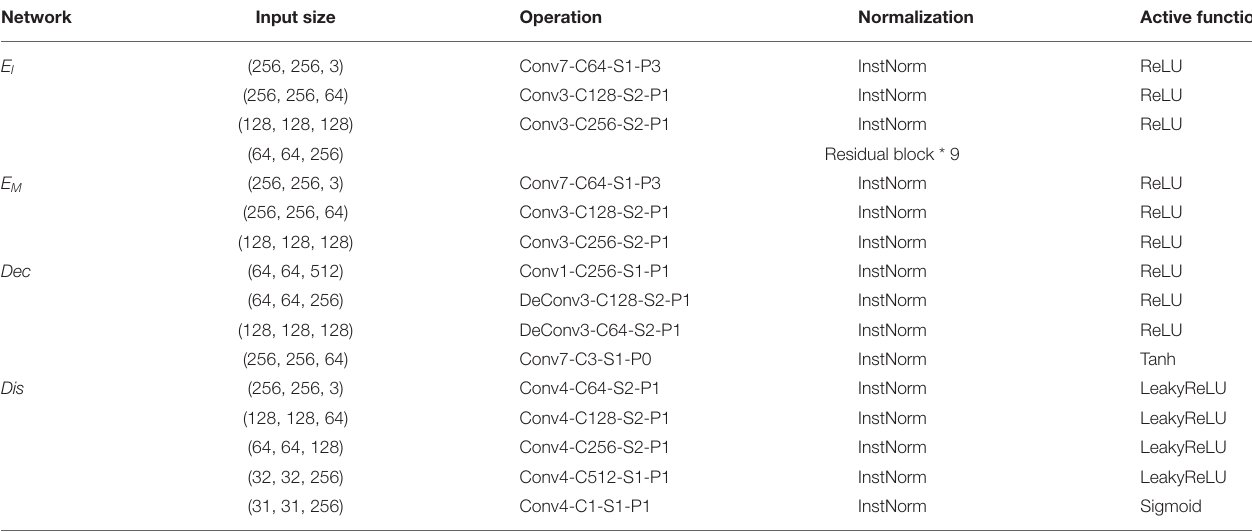
TABLE 2 | The architecture details adopted in our algorithm. Network Input size Operation Normalization Active